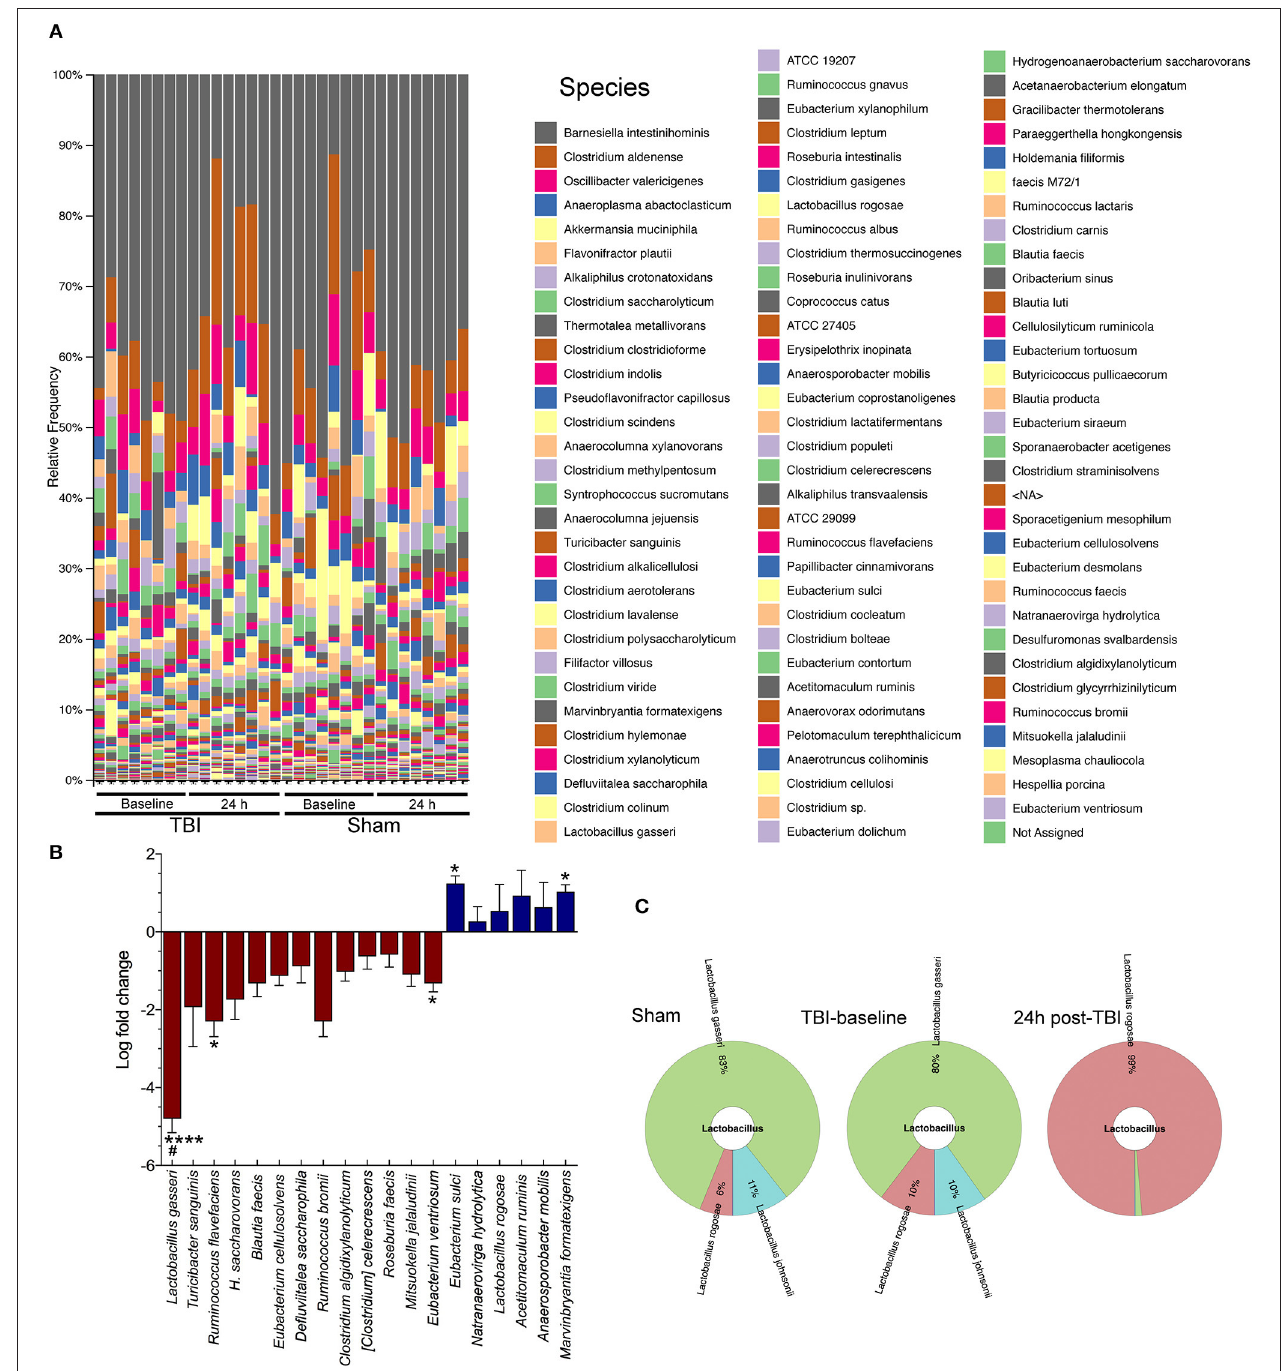
FIGURE 2 | Species-level changes after acute brain injury. (A) The legend indicates each detected bacterial species, ordered from highest relative abundance to lowest relative abundance (colors are repeated). Gray colored bars at the top of each column in the bar plot represents the highest relative abundance of any species: Barnesiella intestinihominis. (B) TBI causes a significant decrease in Lactobacilus gasseri (**** p < 0.0001), Ruminococcus flavefaciens (* p < 0.05), and Eubacterium ventriosum (* p < 0.05) compared to baseline levels; and a significant increase in Eubacterium sulci (* p < 0.05), and Marvinbryantia formatexigens (* p < 0.05). TBI also caused a decrease in L. gasseri (# p < 0.05) with the sham group (baseline and 24h), ( n = 8/group). (C) Krona chart highlights the relative differential abundance within the Lactobacillus family after injury, showing a near complete loss of L. gasseri, johnsonii, and taiwainensis bacteria, leaving L. rogosae as the lone representative in that genus after